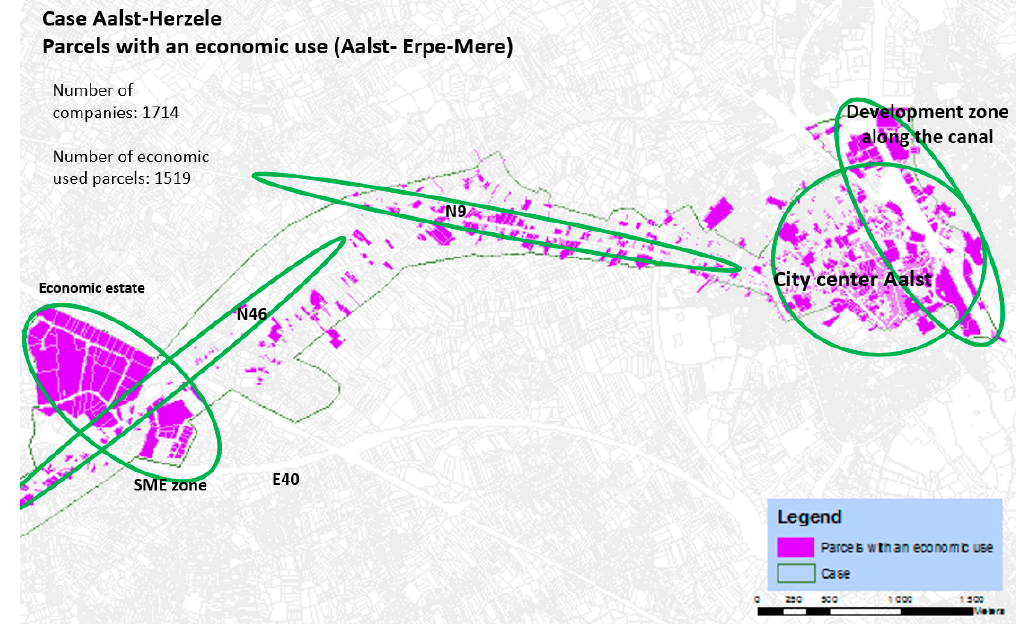
Figure 2. Factual economic use of plots in the Aalst-Herzele case study area.